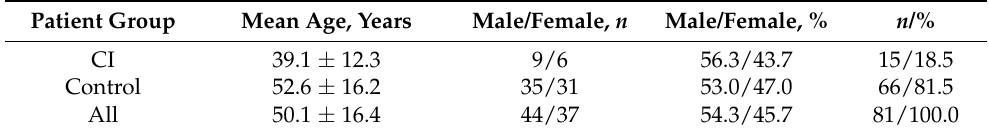
Table 1. Demographic data of the study cohort.